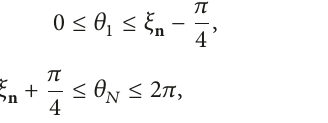
Based on the results in Figure 1, we can conclude that one can identify the shape of existence of Γ 1 for any choice of 𝛼